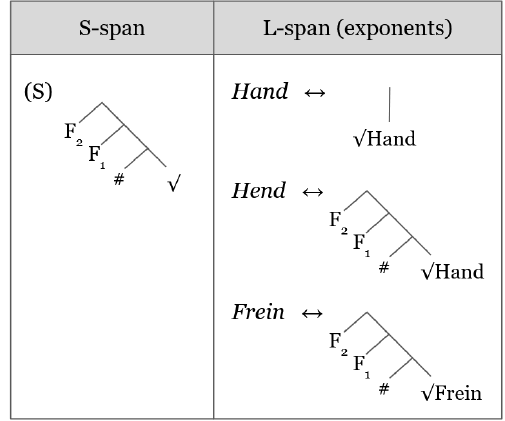
Figure 3. Spellout of PD ‘zero’ and umlaut plurals.